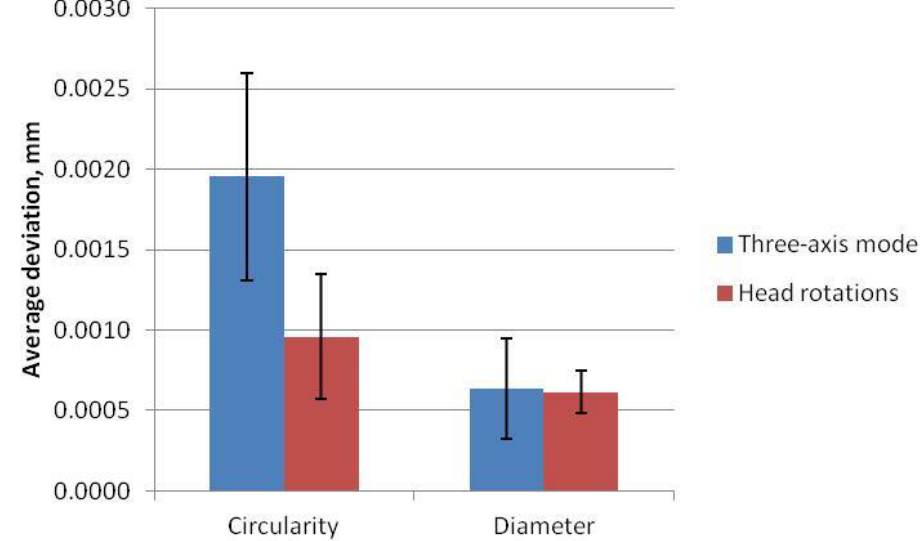
Figure 1. The results of the experiment showing the difference between measurements done using only the classic, three-axis coordinate measuring machine (CMM) and measurements done using measuring head movements. Error bars present the range of individual measurement results.